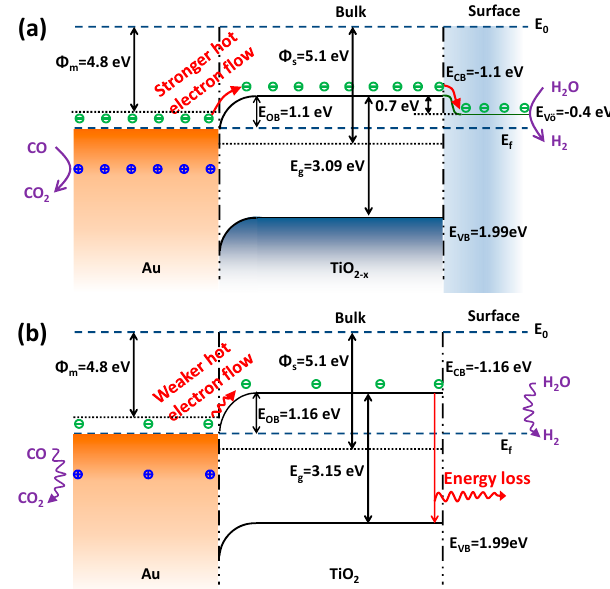
Figure 10. Proposed electron flow process of Au-TiO 2 − x ( a ) and Au-TiO 2 ( b ) for the WGS reaction based on hot-electron flow. Φ m : work function of metal; Φ s : work function of semiconductor; E f : Fermi level; E 0 : vacuum level; E OB : Ohmic barrier, V Ö : oxygen vacancy; E CB : conduction band; E VB : valence band.